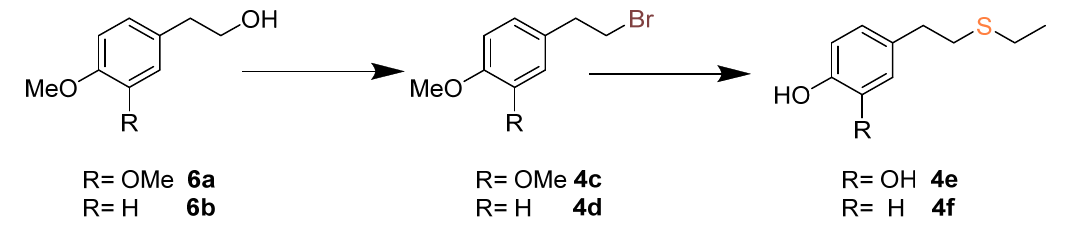
Figure 4. Synthesis of arene derivatives 4c – 4f .